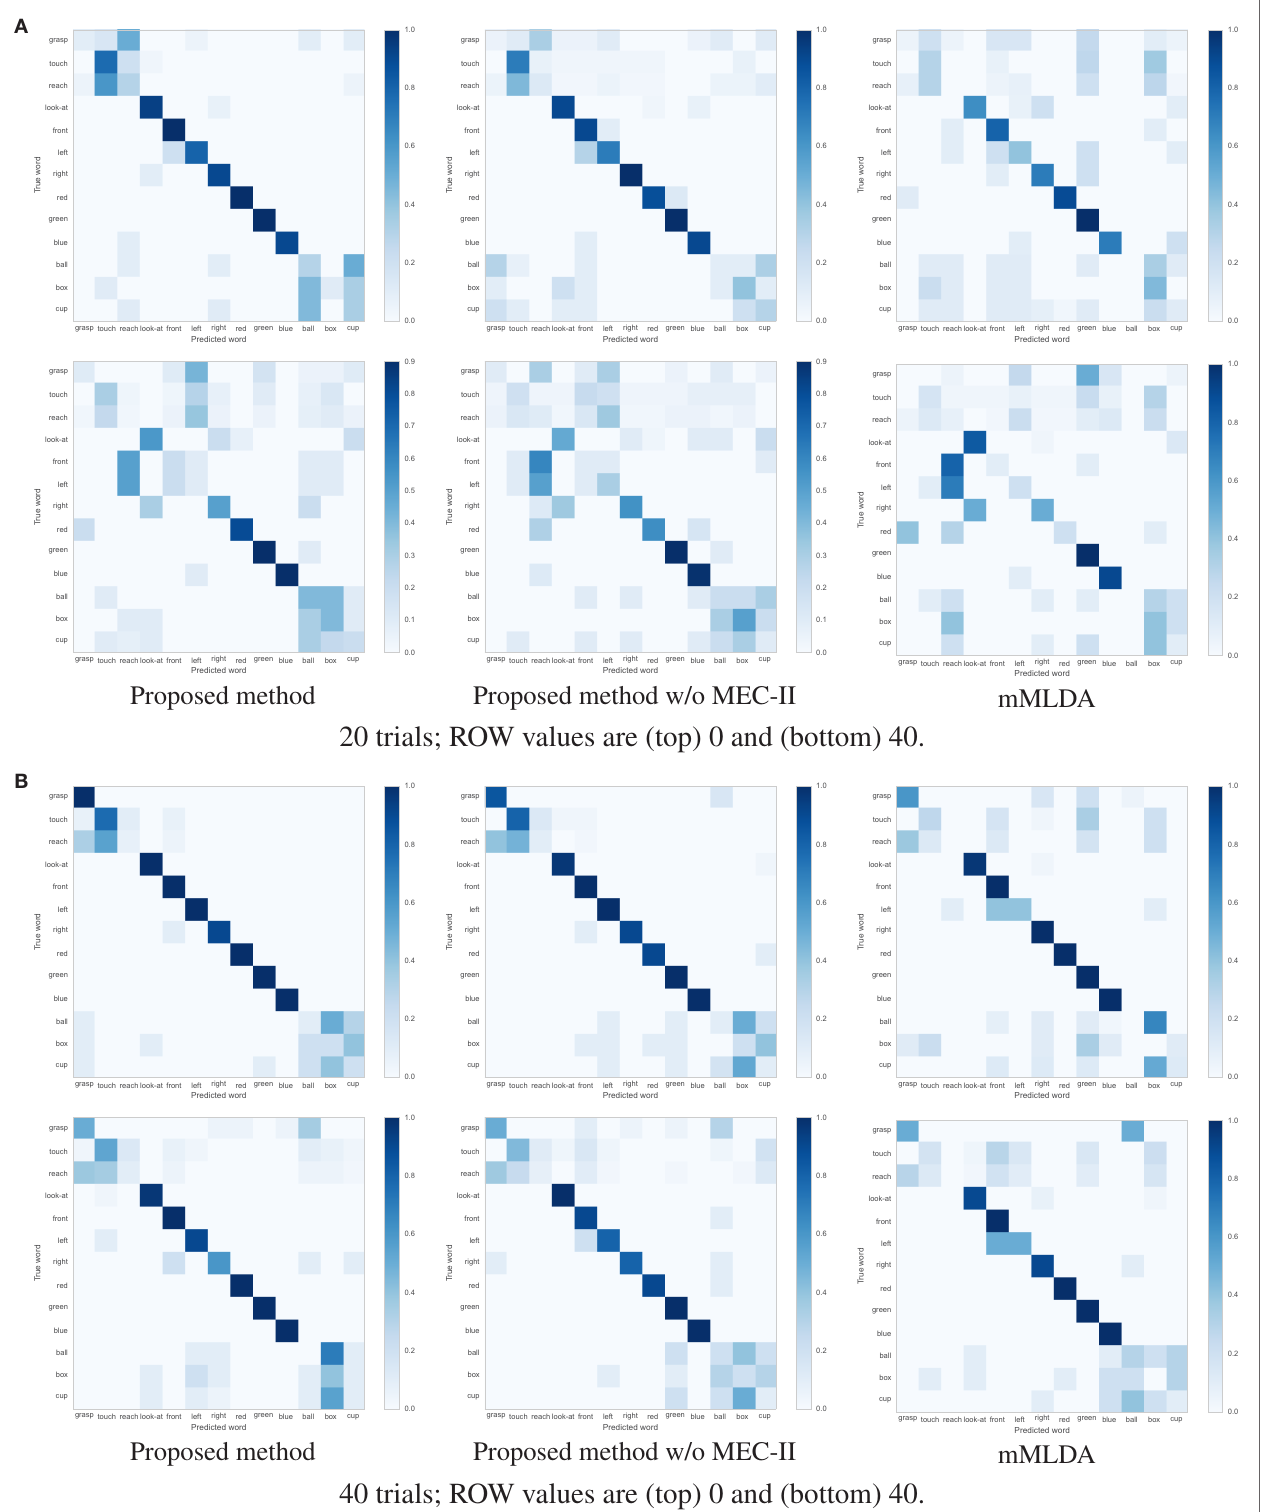
FIGURE 6 | Confusion matrix of results of the action description task using the learning result for 20 and 40 trials. (A) 20 trials; ROW values are (top) 0 and (bottom) 40. (B) 40 trials; ROW values are (top) 0 and (bottom) 40.